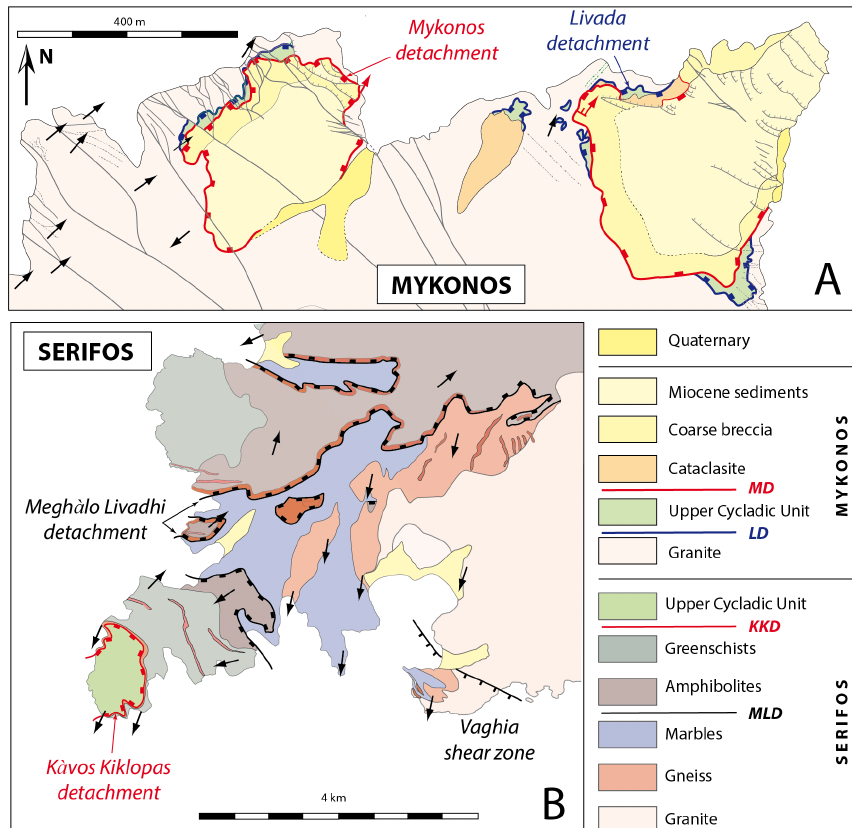
Figure 6. Details of the two detachments on Mykonos and Serifos. (a) Northeastern Mykonos (see location in Fig. 5); (b) southwest Serifos. The Mykonos (MD) and Livada (LD) detachments on Mykonos and the mineralized veins and normal faults (baryte and iron hydroxides) – grey – are after Menant et al. (2013). The Kàvos Kiklopas (KKD) and Meghàlo Livadi (MLD) detachments on Serifos are after Grasemann and Petrakakis (2007) and Ducoux et al.